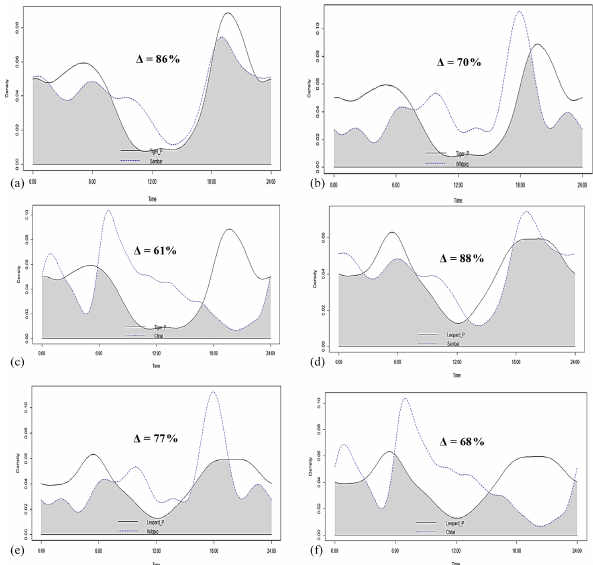
Figure B6. Activity curves and extent of temporal overlap between (a) tiger and sambar, (b) tiger and wild pig, (c) tiger and chital, (d) leopard and sambar, (e) leopard and wild pig, and (f) leopard and chital in Pench Tiger Reserve, Madhya